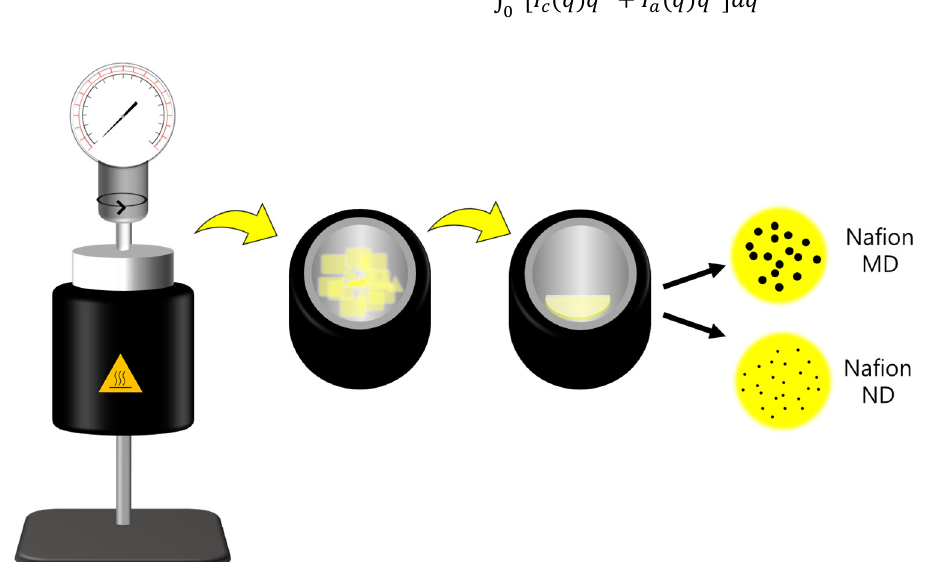
Figure 1. Preparation process schematic diagram of Nafion ionomer micro/nano-dispersions. In Equation (1), λ represents the wavelength of Cu-K a light used for analysis, and I a ( q ) and I c ( q ) represent the peak intensities of amorphous and crystalline wavelengths, respectively. The degree of crystallinity was expressed by dividing the crystal scattering area by the sum of the crystal and amorphous scattering areas. At this time, 2 θ values corresponding to crystalline and amorphous in the XRD diffraction pattern of the PFSA ionomer dispersion are 16° and 17.5°,